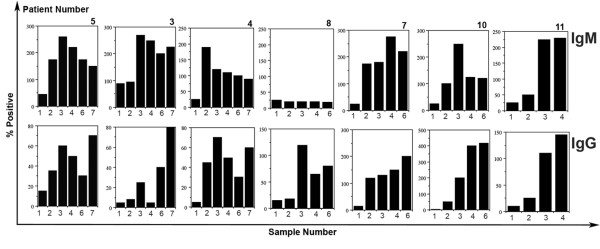
Antibody (IgM and IgG) responses to VNTR in patients immunized with M-FP. Representative examples from patients 3, 4, 5, 7, 8, 10 and 11. 1 = first injection; 2 = week 6 (2 weeks after the third injection); 3 = week 12 (2 weeks after the sixth injection); 4 = 6 months (3 months after the seventh injection); 6 = 1 year and 3 months after the final (ninth) injection; 7 = 2 years, and 1 year and 3 months after the final injection. A positive control serum was selected from a panel, being from a patient previously immunized with M-FP (IFCM10_#2EC) who had developed an anti-VNTR antibody response. Negative control serum was selected from a panel, being from a normal individual (ARI_#S2P) with no detectable anti-VNTR antibody. The antibody reactions are presented as percentage positive of test sera compared with positive control sera (where the negative control serum reaction was <15% of positive serum). M-FP, oxidized mannan conjugated to MUC1 fusion protein; VNTR, variable number of tandem repeats (from MUC1 sequence).